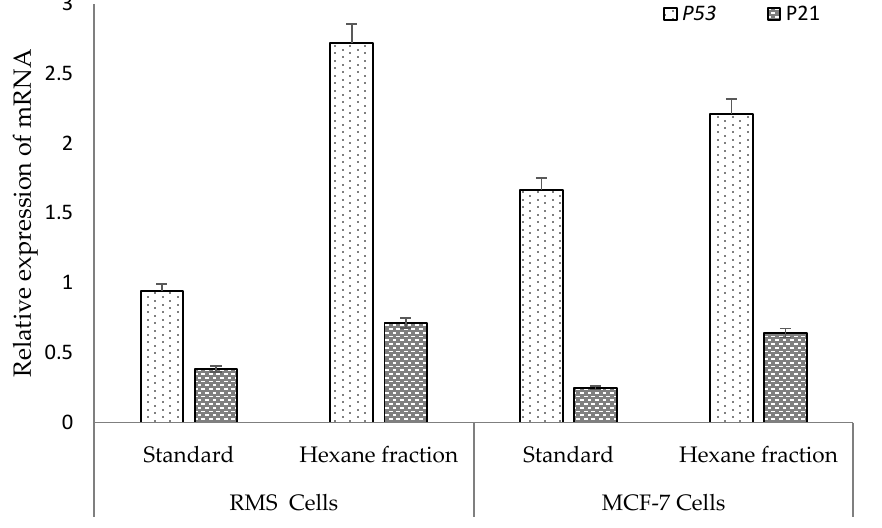
Figure 13. The p53 and p21 genes’ relative expression of RMS and MCF-7 treated with hexane fraction (90 μg/mL) and standard cycloheximide (30 μg/mL).